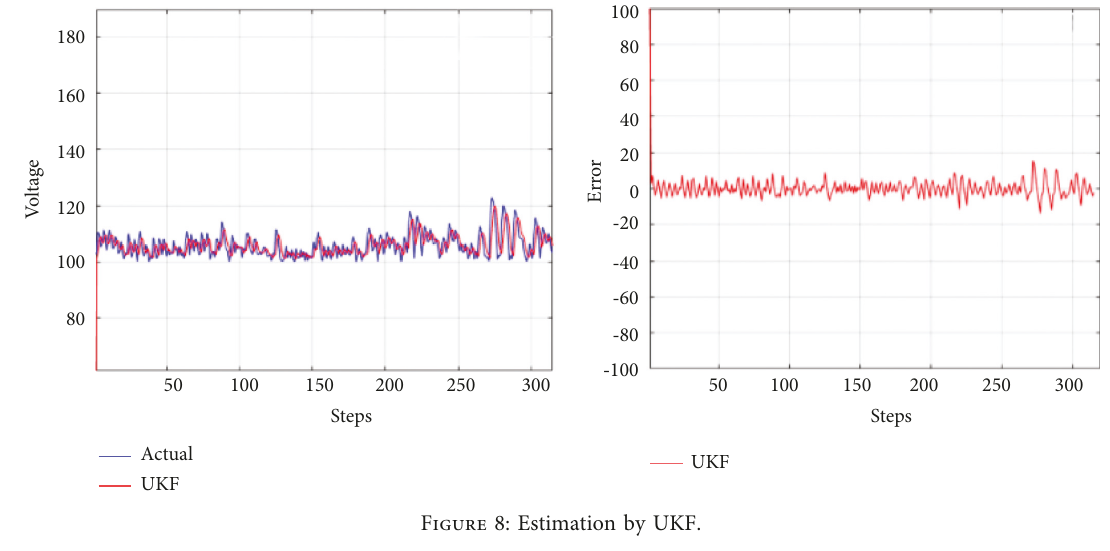
Figure 8: Estimation by UKF.